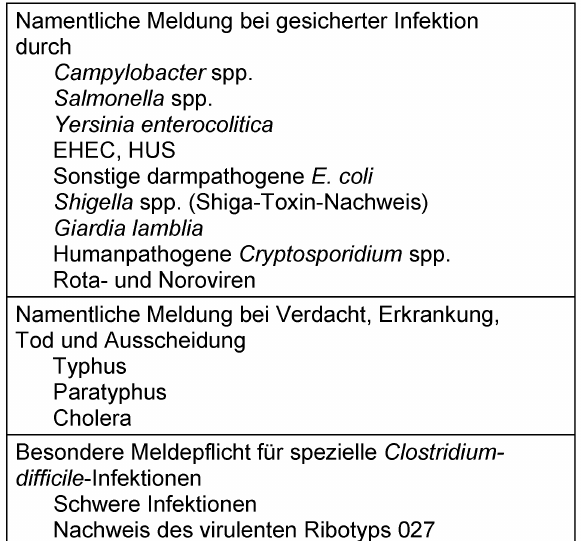
Tabelle 2: Meldepflichtige gastrointestinale